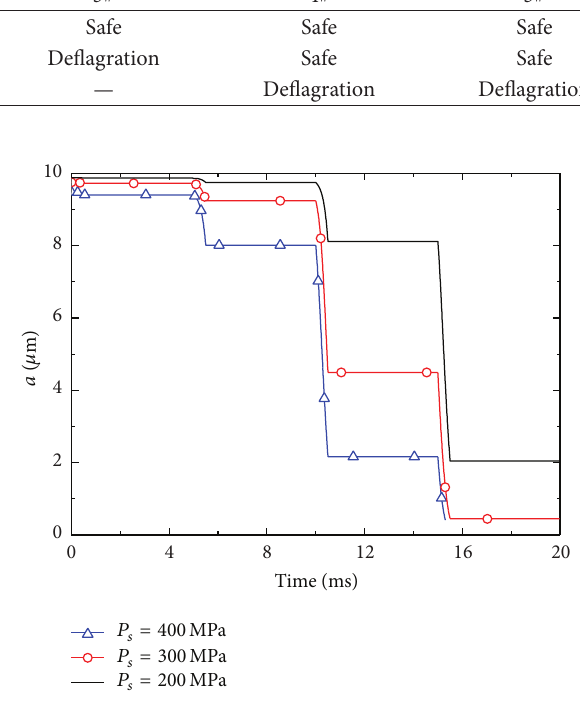
Figure 9: Time evolution of damage level when the explosive was loaded by four repeated pulses.